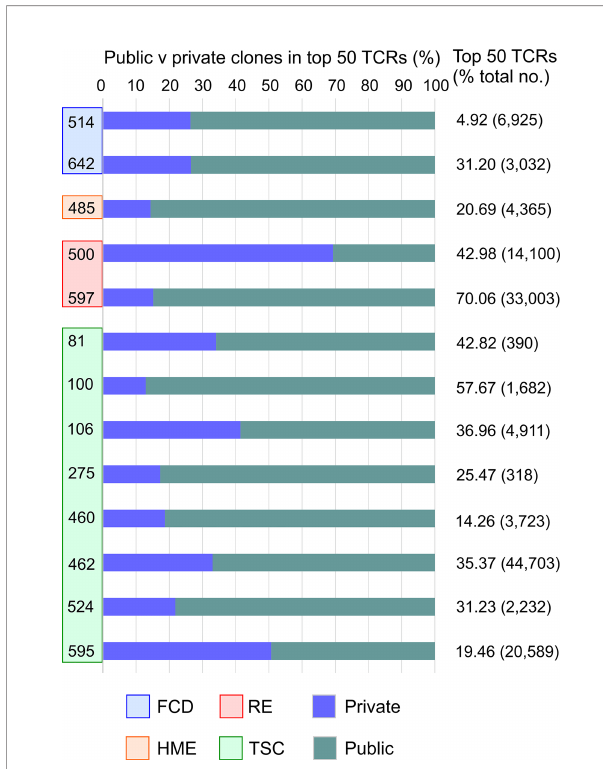
FIGURE 3 | The top 50 T cell clonotypes in brain comprise public and private clonotypes. Bar graphs showing the relative proportion of public and private clonotypes in the top 50 T cell clonotypes from each patient along with the percentage of the total sampled repertoire that each of the top 50 clonotypes represents. The total number of clonotypes identi fi ed is shown in